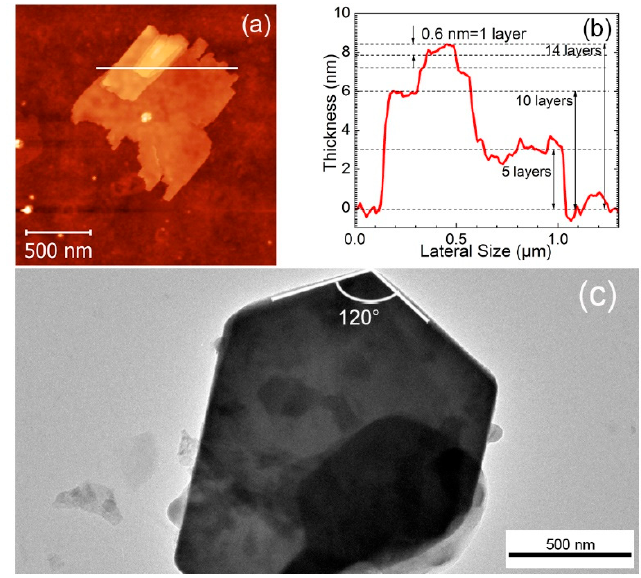
Figure 2. ( a ) AFM picture of the 2 h ball milled and 90 min sonicated WS 2 , ( b ) thickness profile of the stacked flake along the white line of Figure ( a ), ( c ) low-resolution TEM picture of an exfoliated flake.